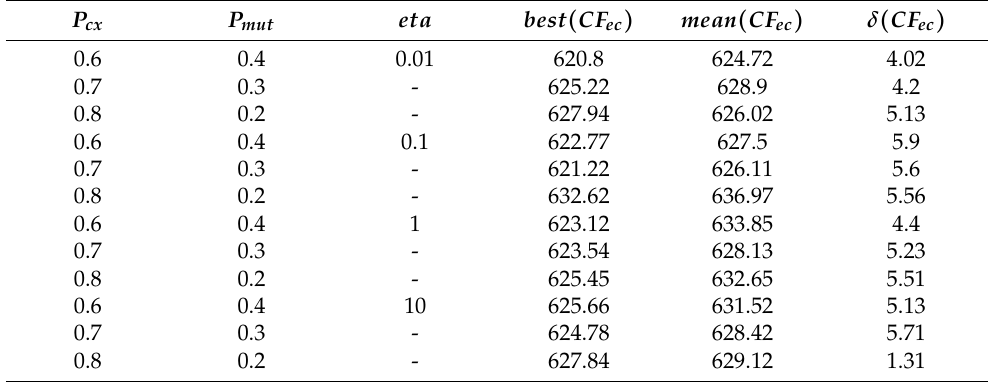
DE 0 0 0 0 0 0 0 MT 1 1 1 1 1 1 1 1 0 0 BESS 0 0 0 0 0 − 1 − 1 − 1 Table 7 shows the results of the objective function with each mutation probability, and cross variation as given in the GA. The results show that the optimal cost function is 620.8 € with P cx = 0.6, P mut = 0.4, and eta = 0.01, where P cx and P mut represent the probability of crossover and mutation of the generated generations, respectively; best ( CF ec ) represents the best value of the cost function for each crossover and mutation probability; and mean ( CF ec ) represents the average value of the cost function for each of the crossover and mutation probabilities. It can be seen that the optimal cost function with the MIP approach is much cheaper than for GA, as shown in Figure 8, which is 605.032 € , 15.768 € less than GA. This big difference occurs because, in the GA approach, the system is less stable, and the BESS output power changes up and down continuously, causing the cost to rise. On the other hand, the MIP approach makes the system more stable, while the BESS output only slightly fluctuates, which makes the objective cost function significantly less. Table 7. Objective function results of the GA approach system with the use of BESS. P cx P mut eta best ( CF ec